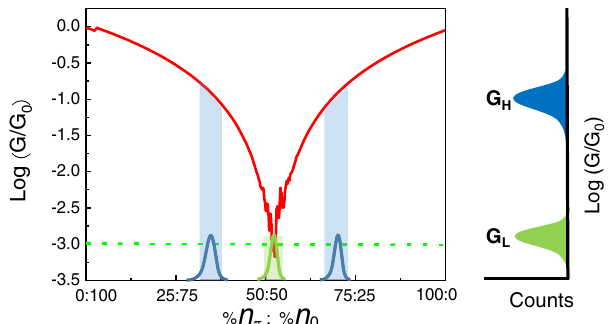
Fig.7|Theeffectofphaserandomizationontransport. Calculatedconductance of a 2D MEJ with one transverse mode at the Fermi level based on Eq. 1. The red curve, calculated for N molecules = 1000 shows how the total conductance changes with the n π : n 0 ratio. When the phase is uniform on both ends of the curve, the conductance (see Eq. 1) is proportional to N 2 molecules . The dashed green line is the conductance based only on the fi rst term in Eq. 1. The green and blue Gaussian curves show the requested phase-population change in order to result in the bi- modal conductance behavior shown on the right with two conductance peaks separated by two orders of